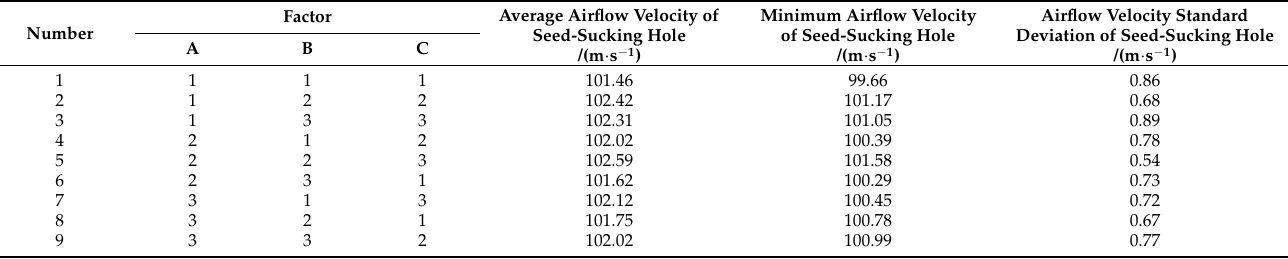
Table 2. Simulation experiment